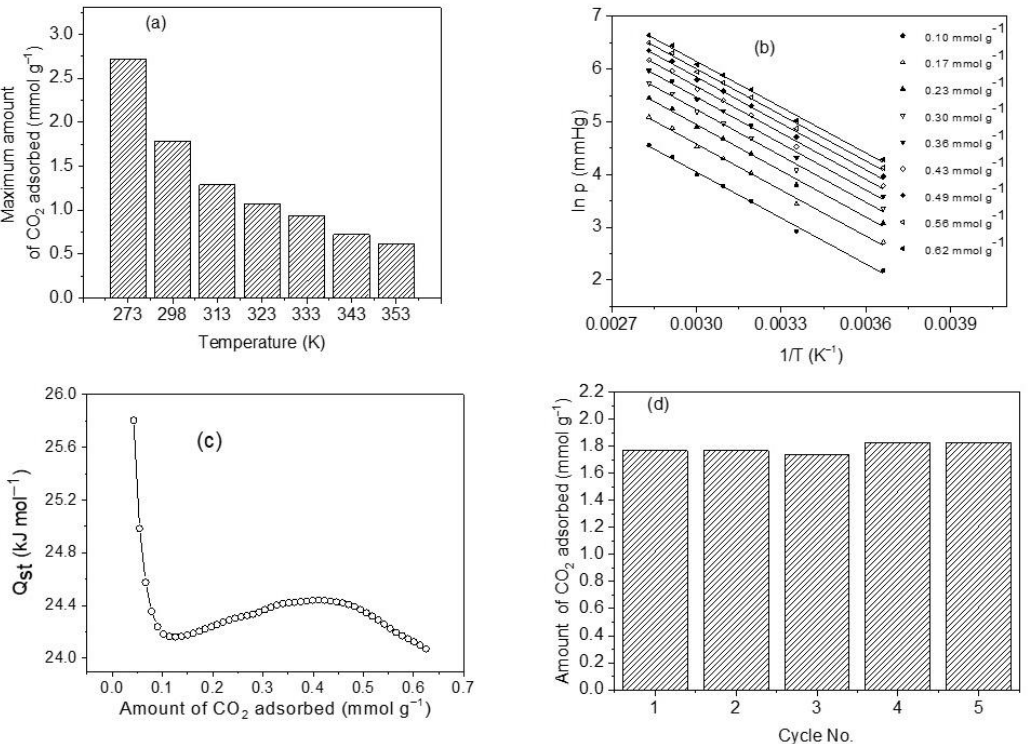
Figure 10. ( a ) CO 2 adsorption capacity of sample M11 of CoHCFs at a temperature range of 273 – 353 K; ( b ) isosteres of CO 2 adsorption as a function of temperature and amount adsorbed on sample M11